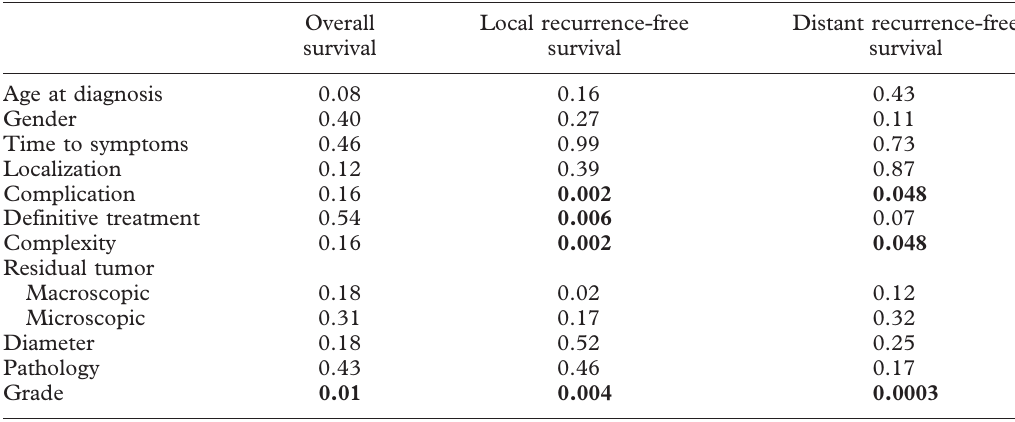
Table 3. Data ( P values) on the potential prognostic factors of initial irradical excision of soft tissue sarcoma in 86 patients (significant p <0.05)